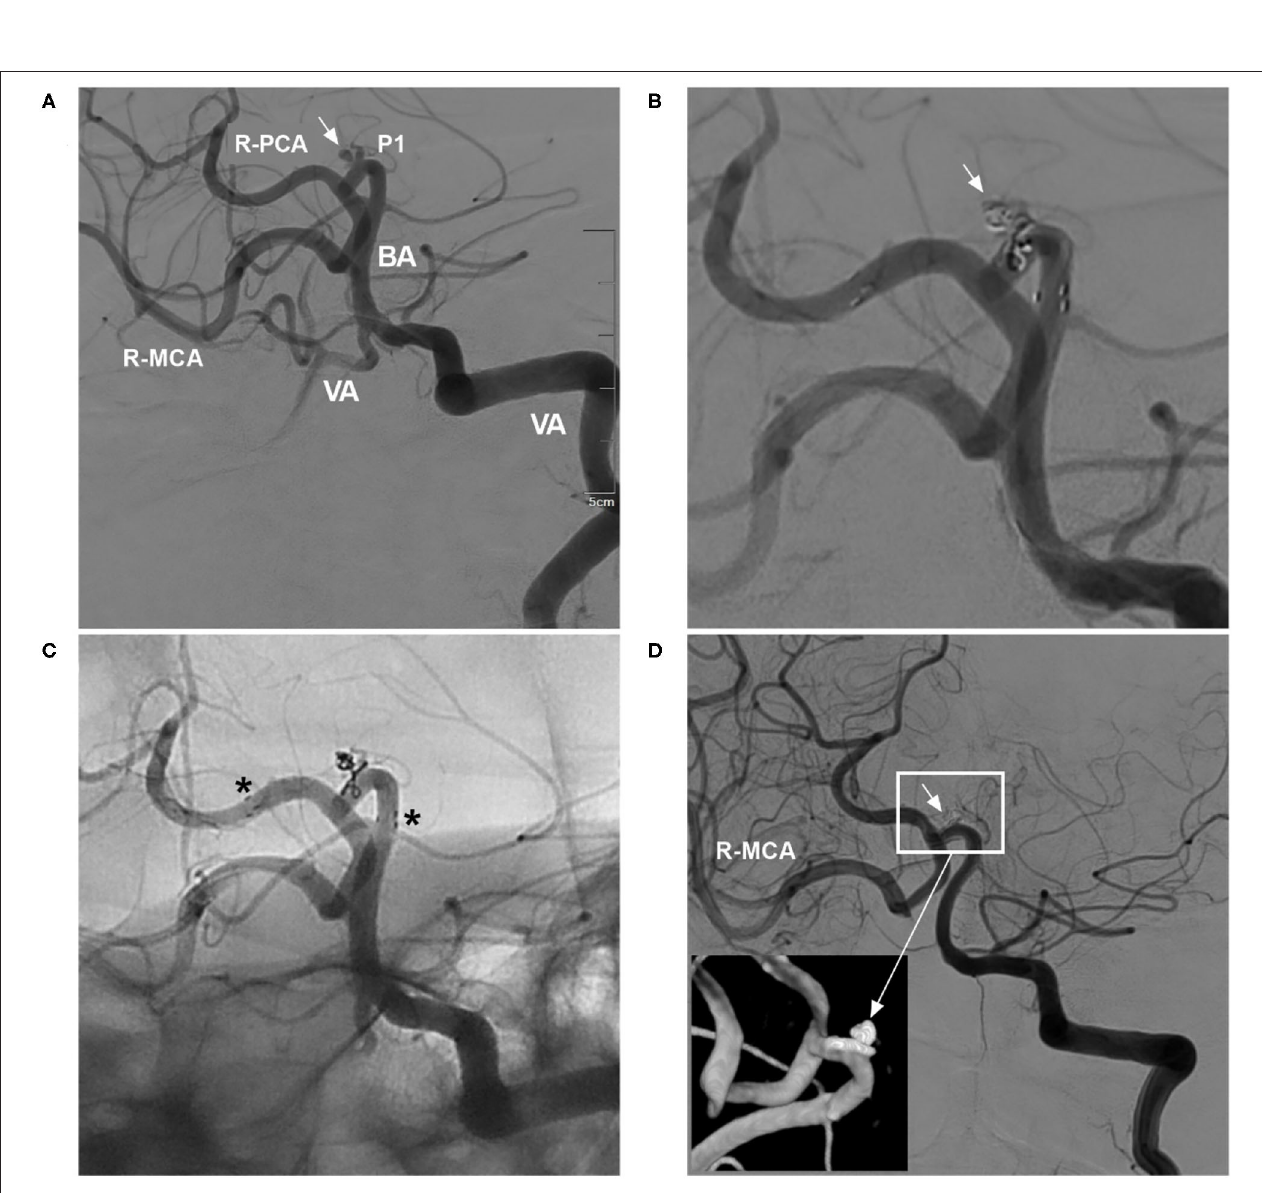
FIGURE 1 | aneurysm; the asterisks in the right image indicate the proximal and distal markers. (D) NAS-assisted coiling of an AcomA aneurysm; the asterisk in the right image indicates the distal marker. (E) NAS-assisted coiling of an MCA aneurysm; the asterisks in the right image indicate the proximal and distal markers. (F) NAS-assisted coiling of a VA aneurysm; the asterisk in the right image indicates the distal marker. (G) NAS-assisted coiling of a basilar tip aneurysm; the asterisks in the right image indicate the proximal and distal markers, and the bidirectional arrows indicate the aneurysm location. (H) NAS-assisted coiling of a PCA aneurysm; the asterisks in the right image indicate the proximal and distal markers. A1, First segment of the anterior cerebral artery; AcomA, anterior communicating artery; BA, basilar artery; MCA, middle cerebral artery; NAS, Neuroform Atlas stent; OA, ophthalmic artery; PCA, posterior cerebral artery; PcomA, posterior communicating artery; VA, vertebral artery.